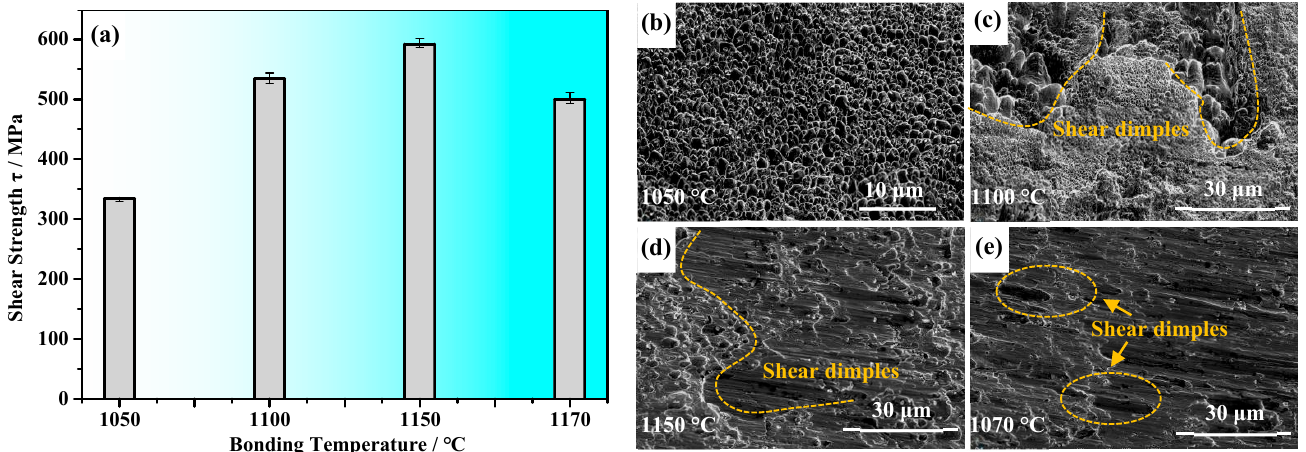
Figure 7. The shear strength and corresponding fracture morphologies of bonding joints with different temperature showing ( a ) shear strength and ( b – e ) fracture morphologies of joints at 1050–1170 ◦